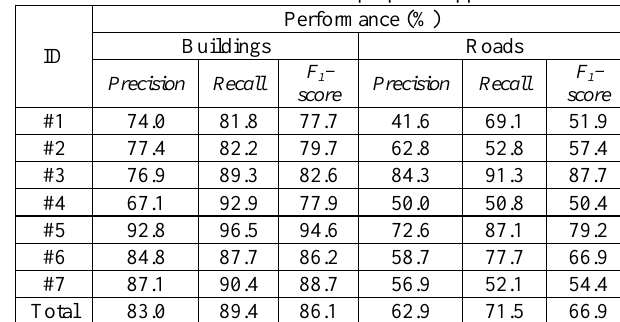
Table 1. Test results of the proposed approach.